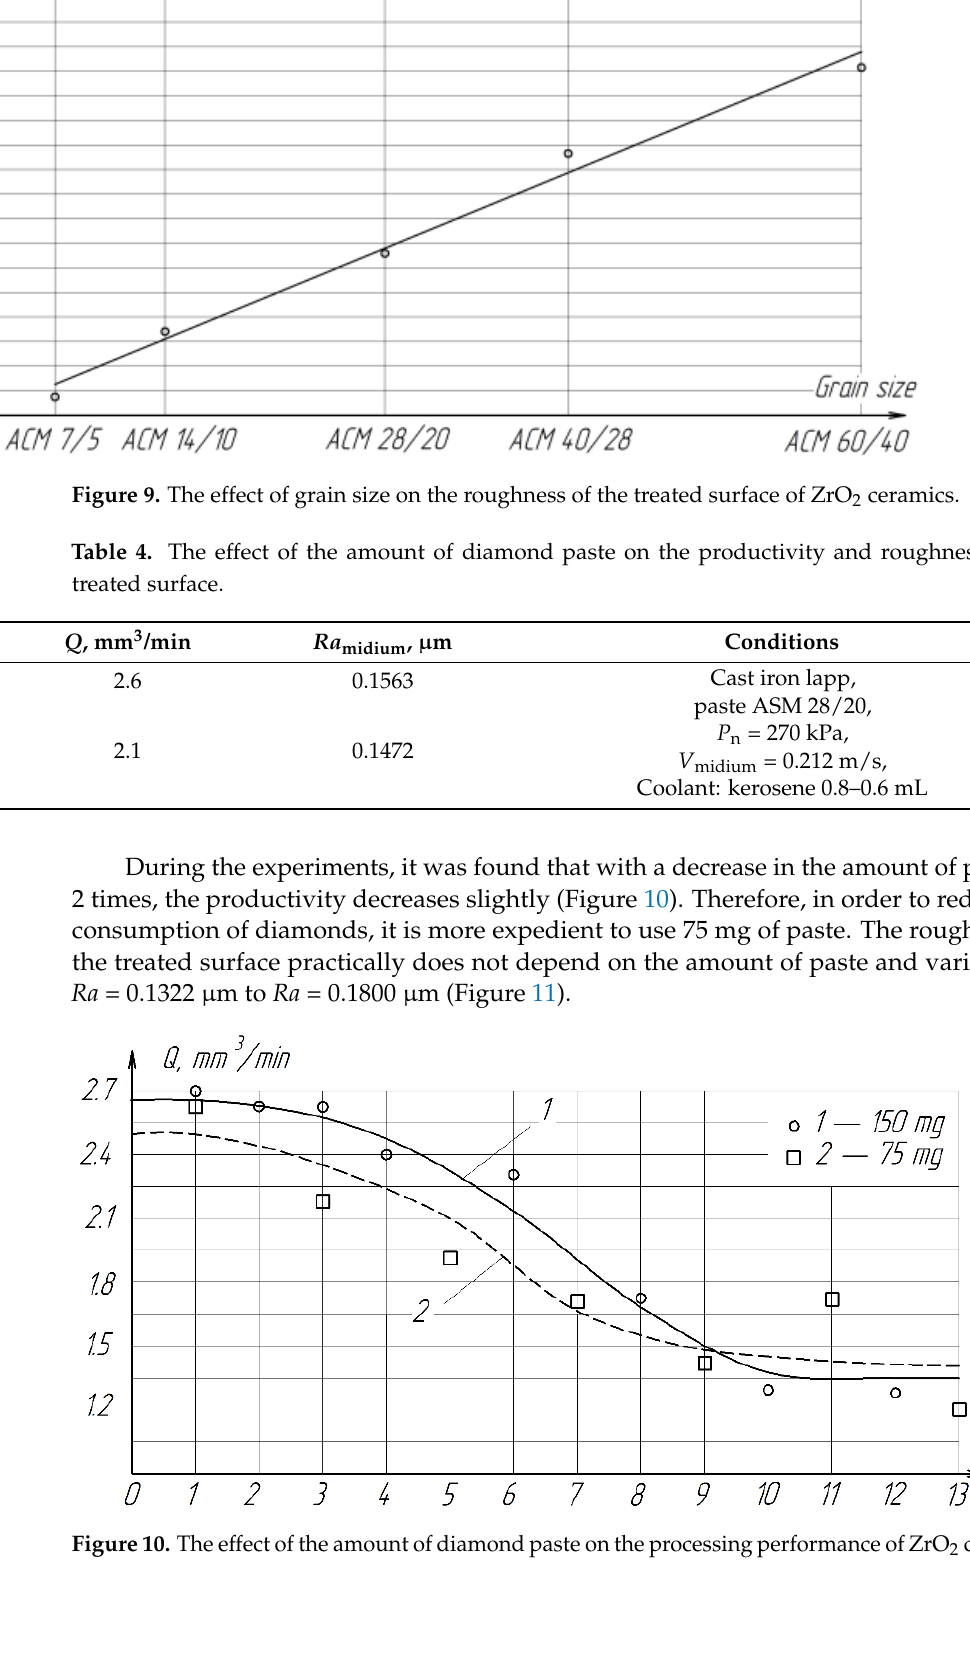
Figure 11. The effect of the amount of diamond paste on the roughness of the treated surface of ZrO 2 ceramics. With an increase in the amount of paste, the finishing performance increases slightly. The roughness of the treated surface practically does not depend on the increase in the amount of paste from 75 to 150 mg. When fine-tuning ceramic samples to save paste, the optimal amount applied to the surface of the paste with a diameter of 220 mm paste is 75 mg. The processing time is most often determined empirically, since it depends on a large number of factors: the lapping material and the parts being processed, the material and consistency of the abrasive mixture, processing modes and the amount of allowance for finishing. To determine the optimal time of the ceramic processing cycle, experiments were carried out on a single “spread”. Every 1–2 min, the productivity and roughness of the treated surface were measured. Table 5 shows the results of the experiment.